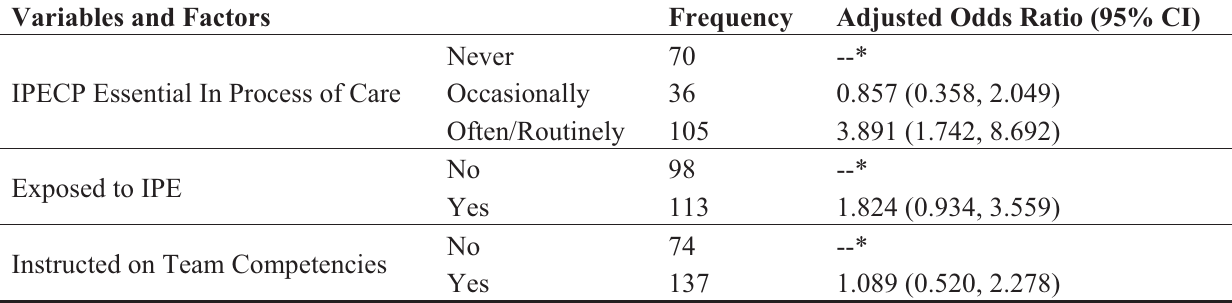
Table 7. Preliminary logistic regression using team care provided as dependent